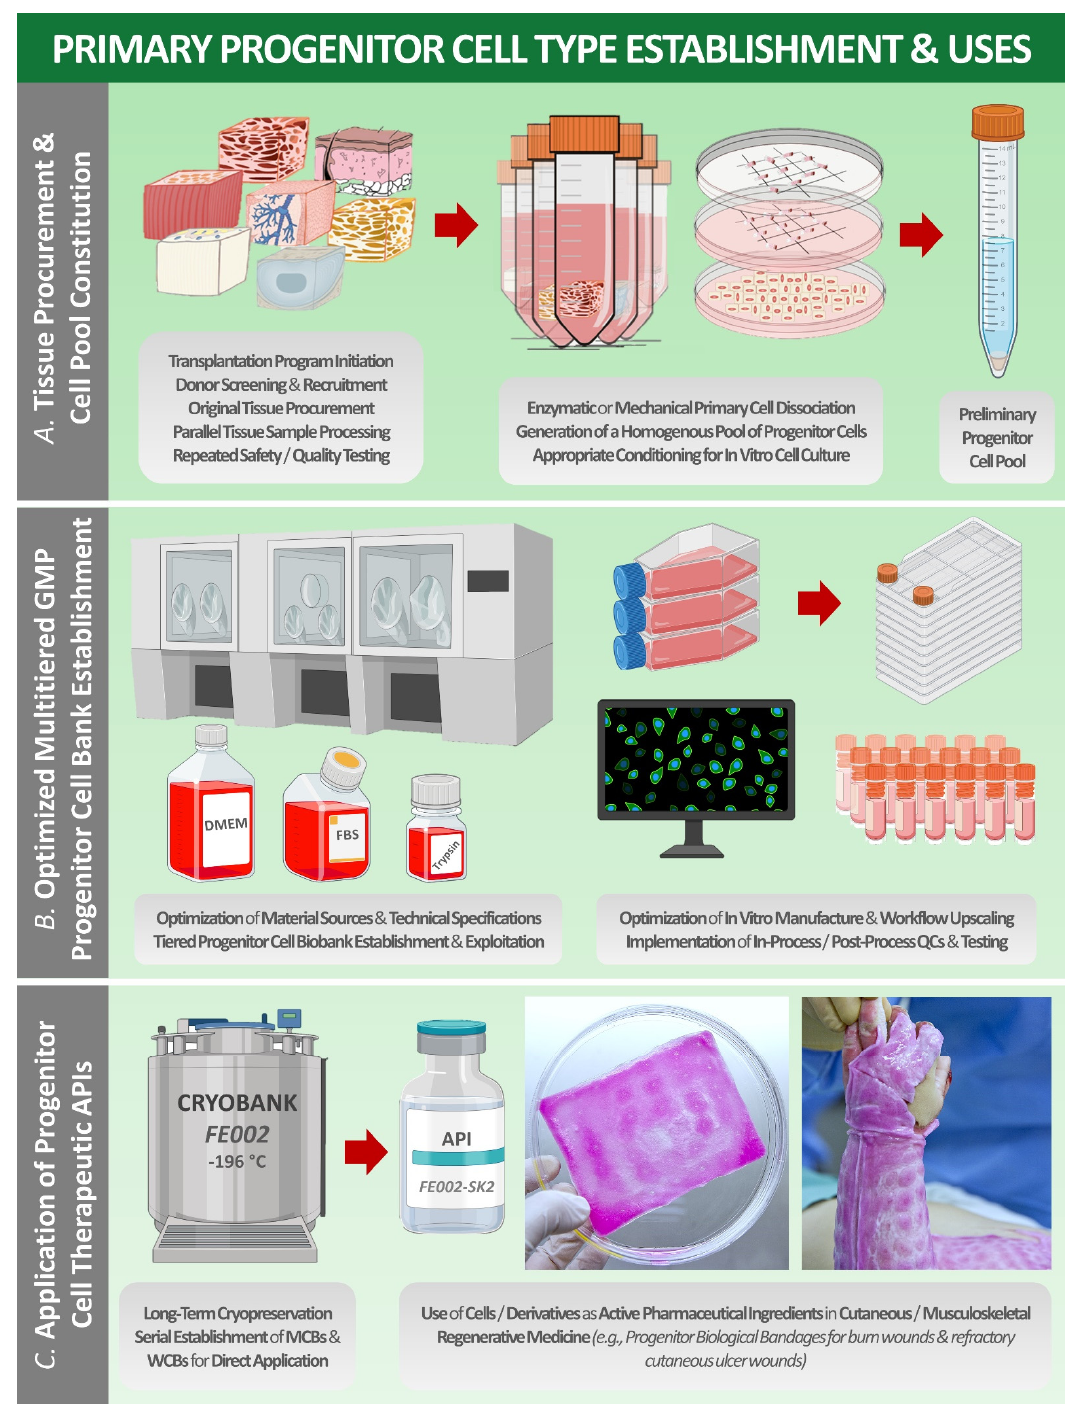
Figure 1. Schematic technical overview of the multiple steps performed in modern settings for the appropriate sourcing, manufacturing, and formulation of clinically compatible progenitor cell-based therapeutic products or standardized transplants. ( A ) Tissue procurement and preliminary progenitor cell pool constitution step. ( B ) Multiparametric technical optimization phase and multitiered GMP biobanking of primary progenitor cells. ( C ) Example of a clinical application of extemporaneously reconstituted skin-derived progenitor cells (e.g., FE002-SK2 fibroblasts), topically applied as viable cells seeded on a collagen scaffold (e.g., PBB product) for pediatric burn patient care in Lausanne under the Swiss progenitor cell transplantation program. API, active pharmaceutical ingredient; DMEM, Dulbecco’s modified Eagle medium; FBS, fetal bovine serum; GMP, good manufacturing practice; MCB, master cell bank; PBB, progenitor biological bandage; QC, quality control; WCB, working cell